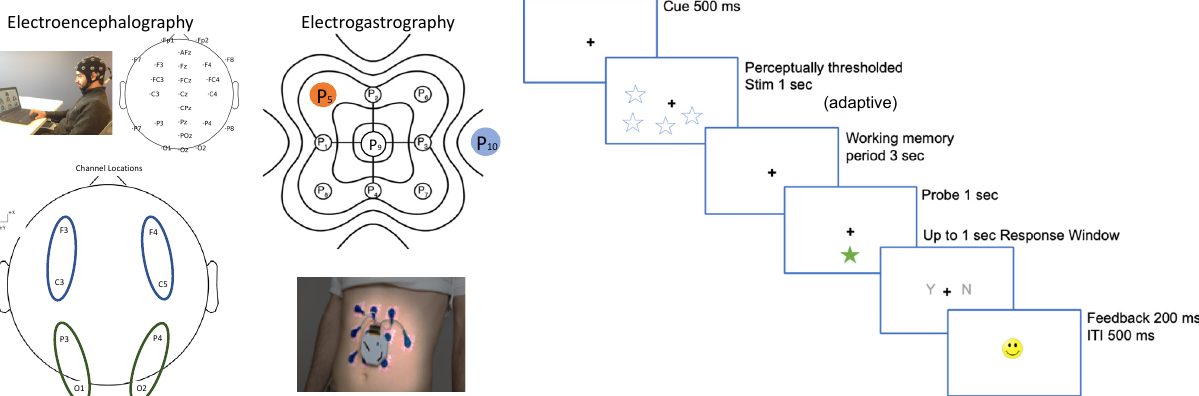
Figure 1. Procedure schematic. ( A ) Recording setup and electrode layout used for our 24 ‐ channel electroencephalography (EEG), highlighted with the 4 different regions (each 2 electrodes, left fronto ‐ central (median of signals from electrodes F3, C3), right fronto ‐ central (F4, C4), left parieto ‐ occipital (P3, O1), right parieto ‐ occipital areas (P4, O2) used for study analysis), and 8 ‐ channel electrogastrography (EGG, red: reference, blue: ground) is shown. ( B ) Task design for the working memory task is shown.